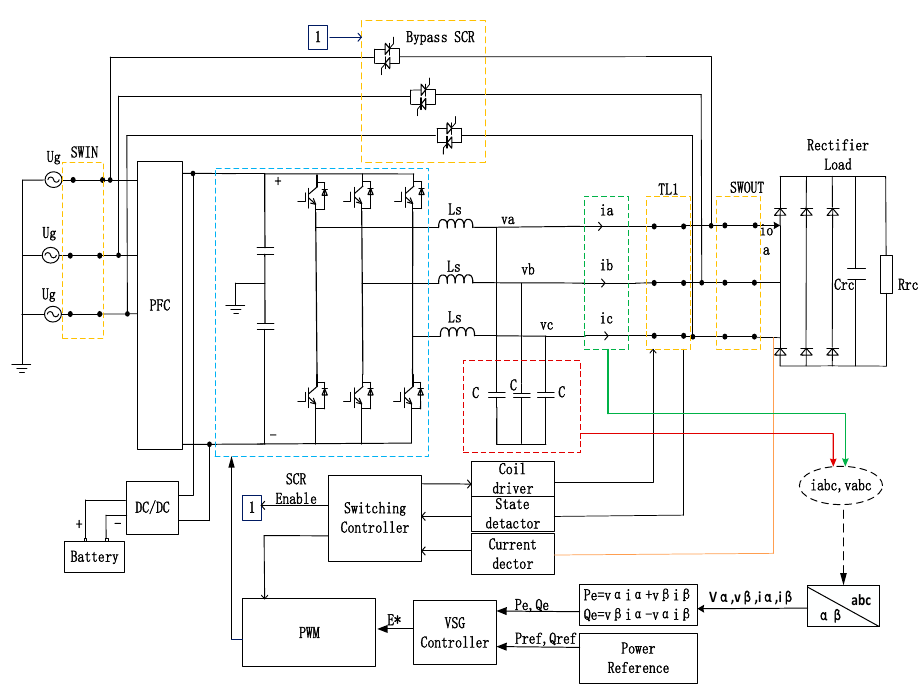
Figure 6. Overall schematic diagram of on-line UPS with proposed control Scheme.